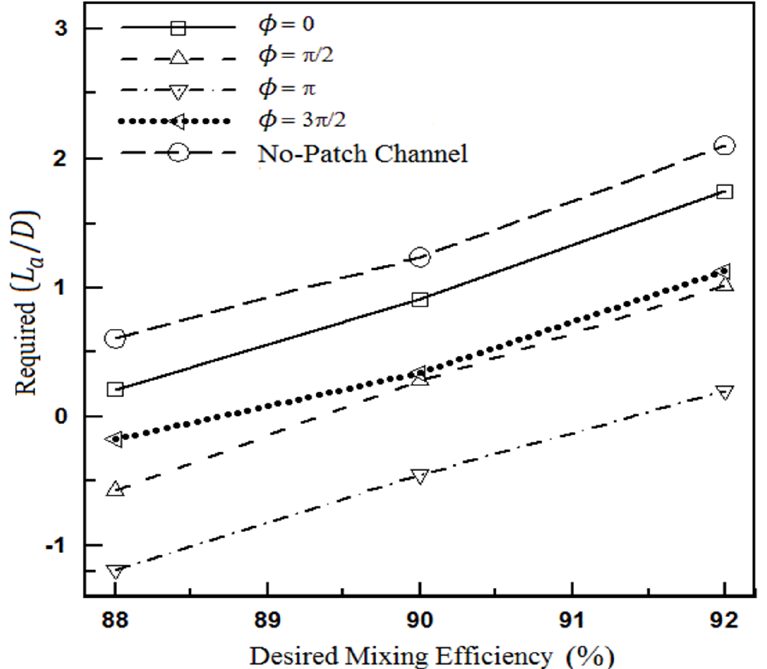
Figure 8. Additional length after heterogeneous section to achieve the desired mixing efficiency for the flow fields of Relations (20) and (21).